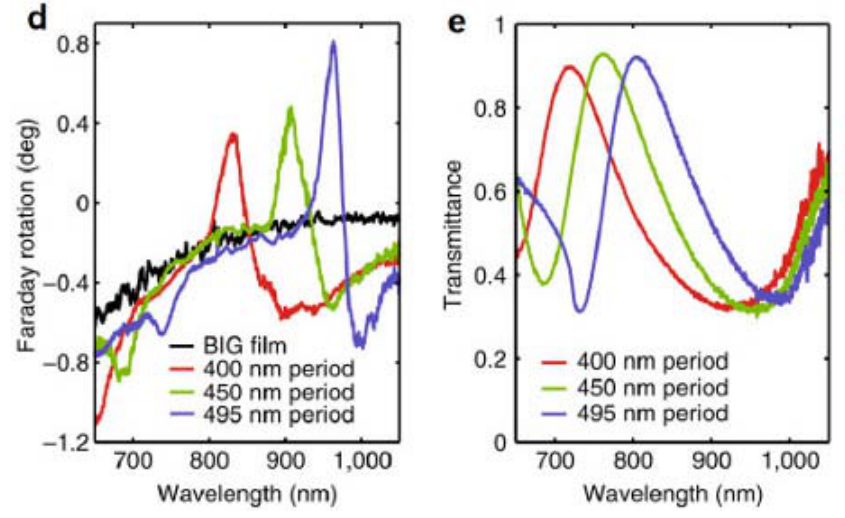
Figure 1. ( a ) Faraday rotation by a magneto-plasmonic photonic crystal for the TM-polarised incident light, where φ is the Faraday rotation angle. At normal incidence, TM-polarised light has the electric field perpendicular to the gold wires; ( b ) Schematic of the magneto-optical photonic crystal, where the BIG film (dark red) is deposited on a glass substrate (blue) and the periodic gold nanowire structure is sitting atop; ( c ) A scanning electron microscopy image of one of the investigated hybrid structures; ( d ) Measured Faraday rotation of the three samples at normal incidence (TM polarization), compared with measured Faraday rotation of the bare BIG film; ( e ) Measured transmittance of the three samples at normal incidence (TM polarization). Reprinted from [44] with permission by Macmillan Publishers Ltd, Copyright